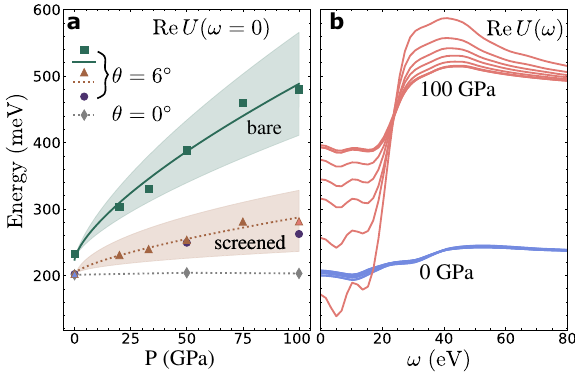
Fig. 4 Dynamically screened on-site interaction. a Screened and bare U ( ω = 0) as a function of pressure for twisted bilayer graphene and screened for the ideal bilayer graphene. Curve labeled with orange triangles is computed in the basis of DFT subspace orbitals, and the curves labeled with violet circles are in the QP basis. The lines connecting the mean values of bare and screened U ( ω = 0) are guide for the eyes. Stochastic error in determining the U is smaller than the marker size. The shaded green and orange area provides the standard deviation from a mean value due to the difference of U ( ω = 0) for individual states within a correlated subspace. b Frequency dependence of the screened U ( ω ) computed in the KS basis at 0 (red) and 100 (blue) GPa pressures. Different curves within one color represent individual 8 states within a correlated subspace. The colors of the curves match the triangles' colors from the left panel at 0 and 100